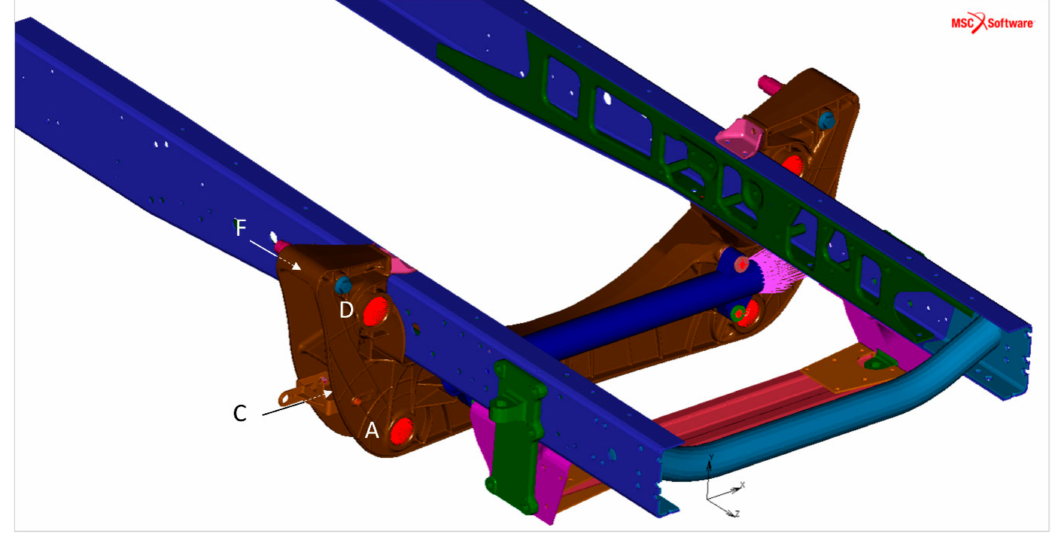
Figure 4. MSC Marc / Mentat model of the cross beam suspension and kinematic hard